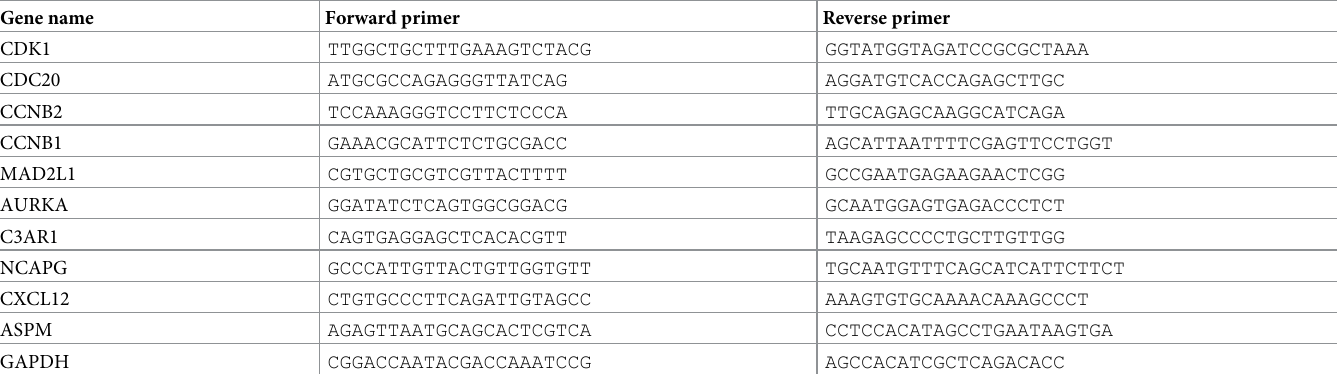
Table 4. The primers of the top 10 hub